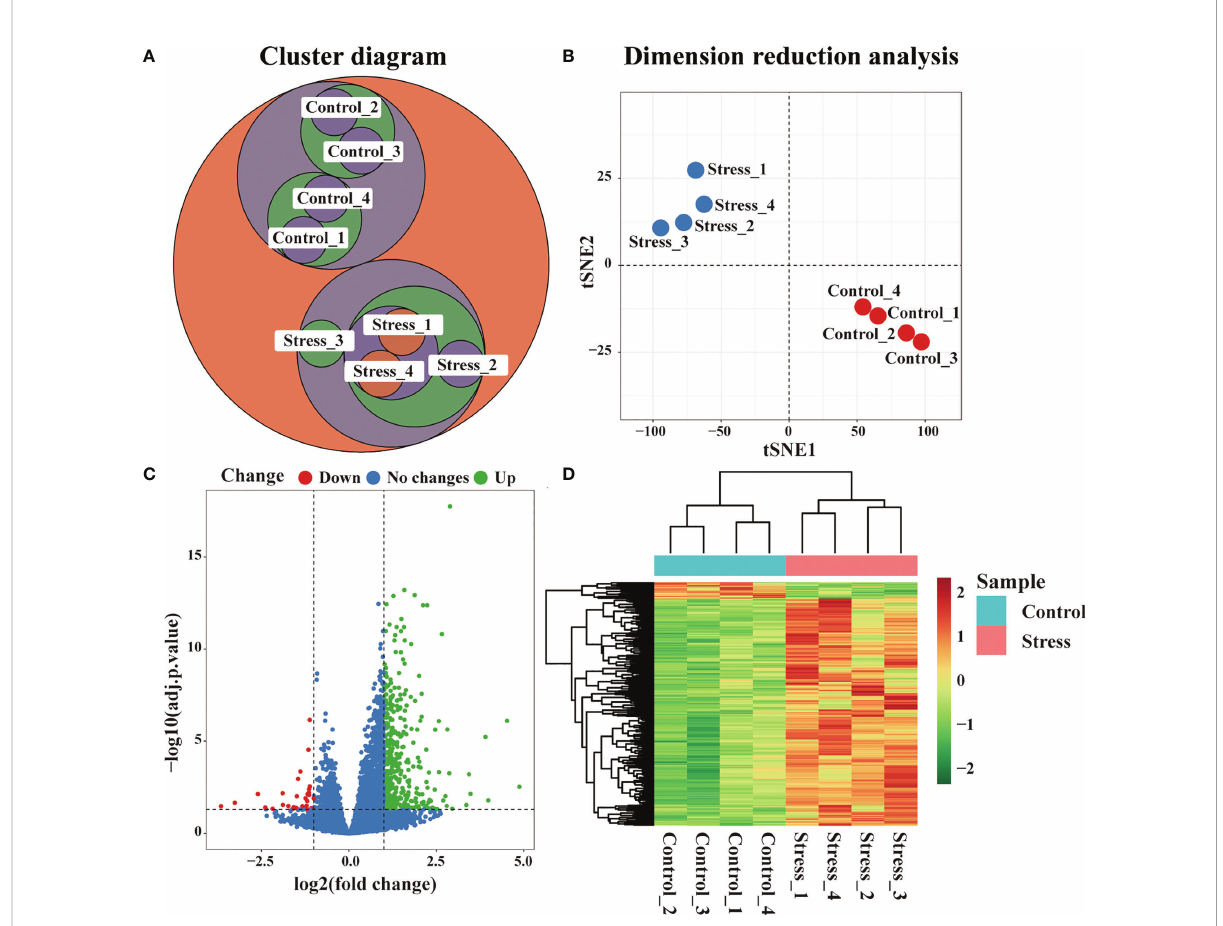
FIGURE 1 Changes of gene expression pro fi le in peripheral blood of mice under acute stress. After 6 hours of restraint stress (n=4) or no stress (n=4), RNA of peripheral blood was extracted and sequenced, and DEG were further screened. (A) Cluster analysis of all samples. (B) Dimension reduction analysis of all samples by t-SNE method. (C) Difference of gene expression between the stress group and the control group displayed by volcano graph. (D) Difference of gene expression between the stress group and the control group displayed by heatmap